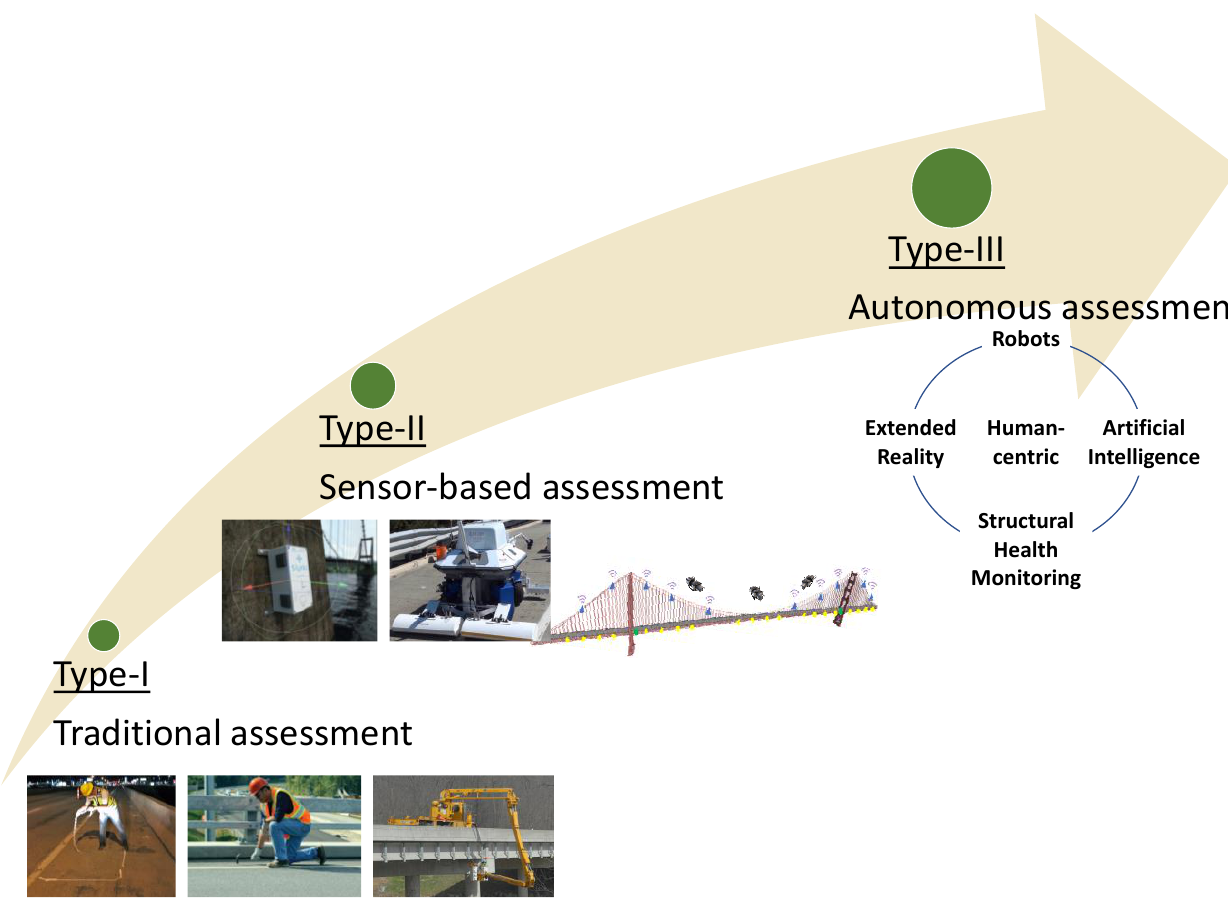
Figure 25. Roadmap for condition assessment of civil structures.